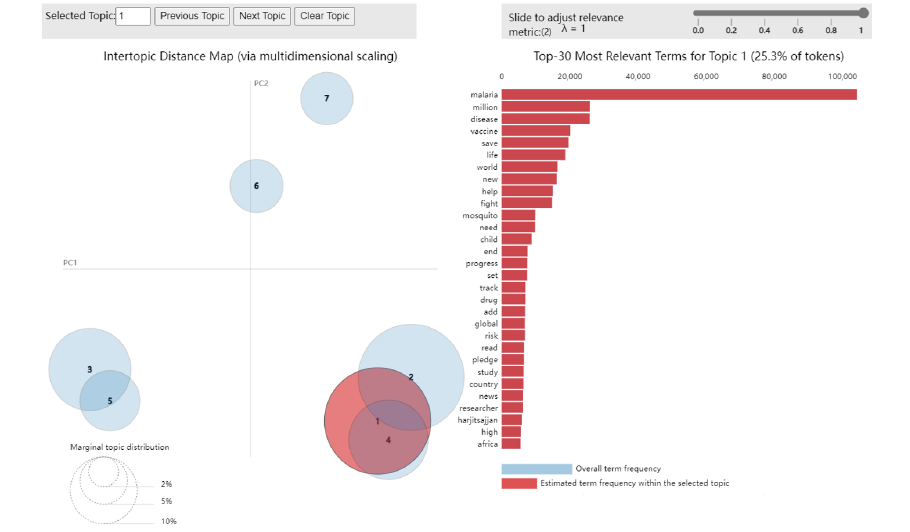
Figure 13. Topic modelling results based on LDA obtained with the pyLDAvis